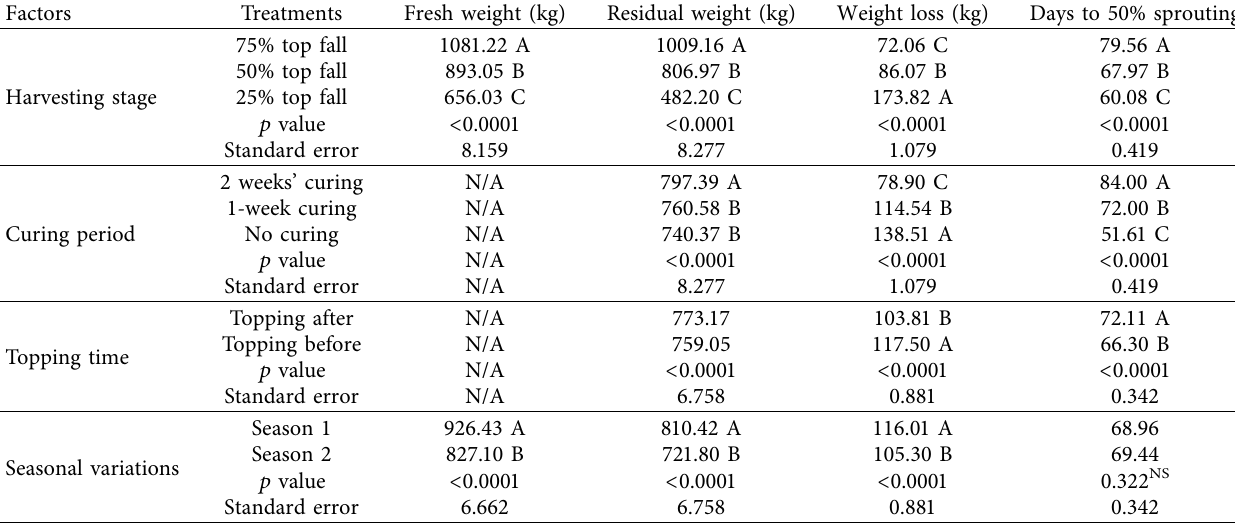
Table 2: Keeping quality of bulb onions subjected to harvest and postharvest treatments.